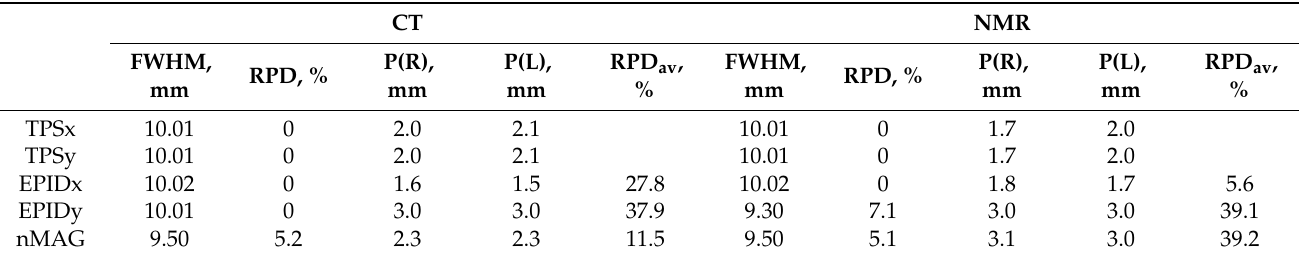
Table 3. The penumbra and FWHM in EPID and polymer gel-measured dose profiles compared with values provided by TPS for 1 cm 2 irradiated field size (transverse plane)